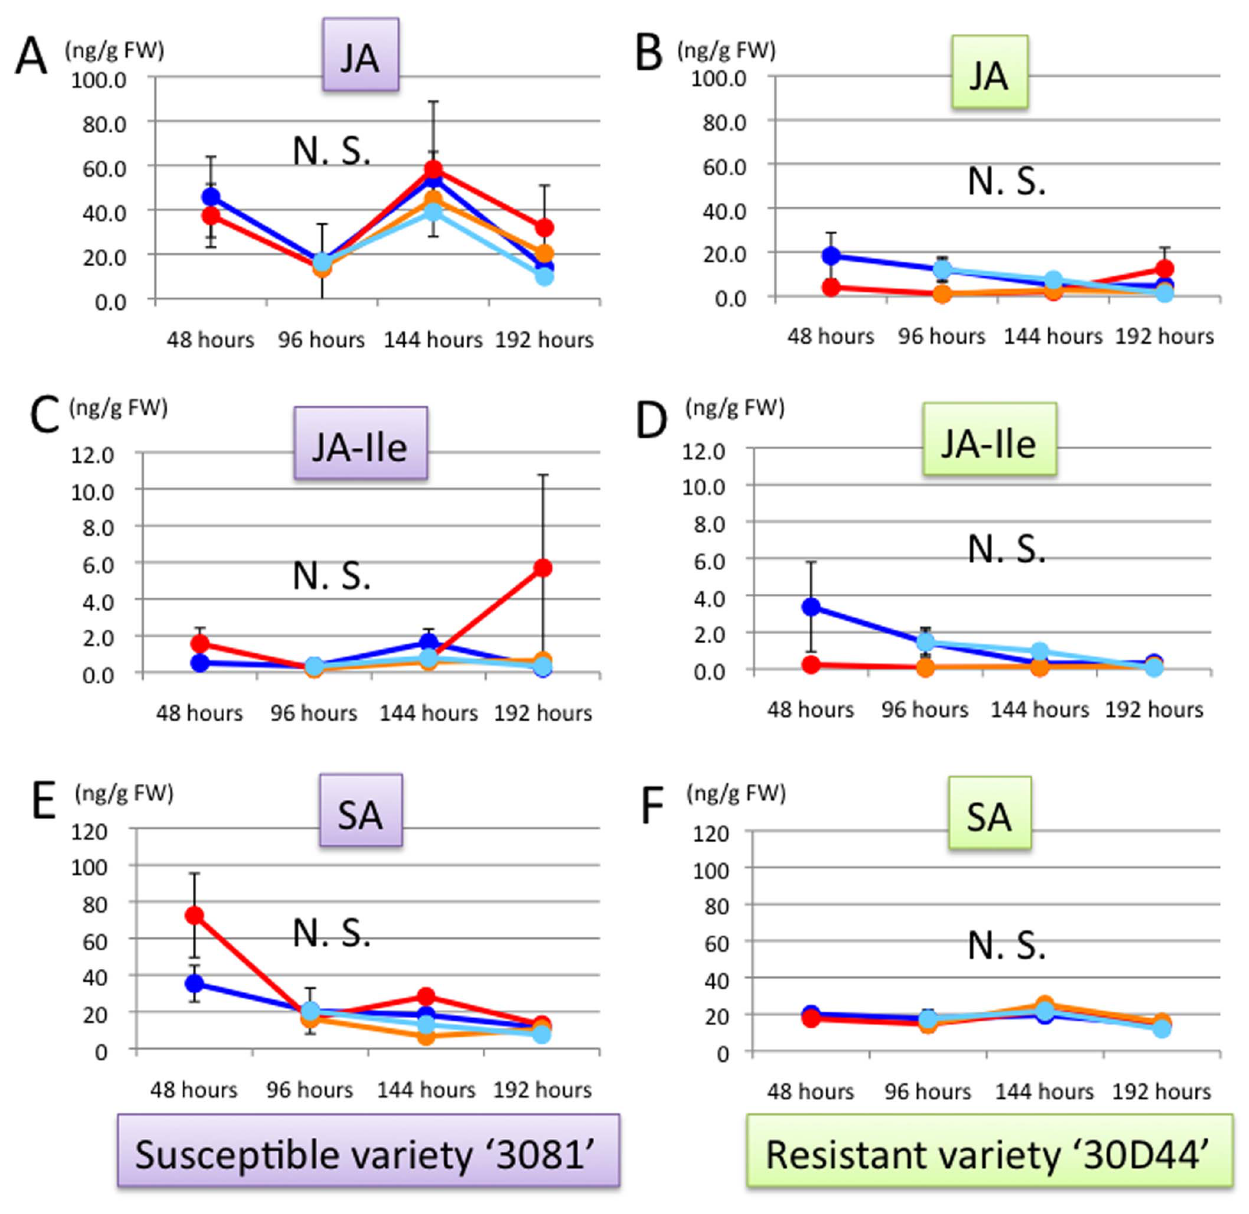
Figure 3. Changes in JA, JA-Ile and SA concentrations in the third leaf of maize. (A) JA concentration (ng/FW) in the variety ‘3081’. (B) JA concentration (ng/FW) in the variety ‘30D44’. (C) JA-Ile concentration (ng/FW) in the variety‘3081’. (D) JA-Ile concentration (ng/FW) in the variety ‘30D44’. (E) SA concentration (ng/FW) in the variety ‘3081’. (F) SA concentration (ng/FW) in the variety ‘30D44’. Line colors indicate leafhopper treatment for eight days (red lines), control (blue lines), early leafhopper treatment for four days (orange lines), and late leafhopper treatment for four days (light blue lines). Different letters indicate significant differences between control and treatments at each time point (ANOVA; followed by Tukey’s HSD test at 144 and 192